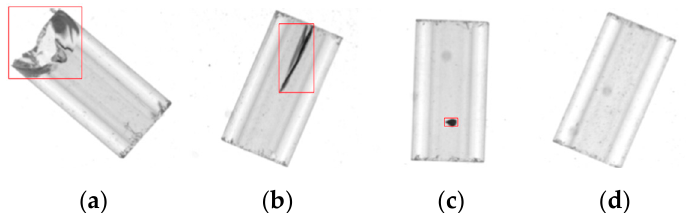
Figure 6. Examples of the diode glass bulb surface defect dataset, and the defect areas are labeled by the red bounding boxes. ( a ) break; ( b ) shell wall damage; ( c ) stain; ( d ) good.